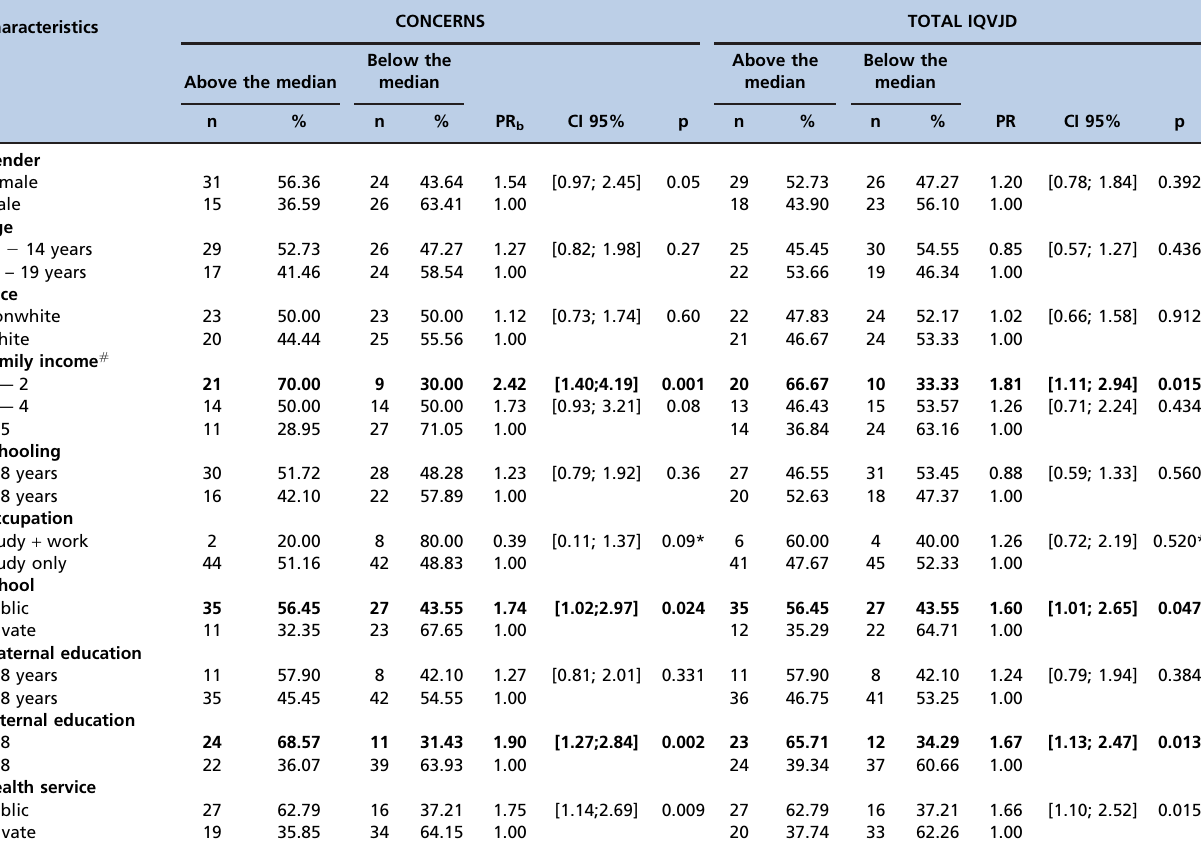
Table 2B - Bivariate analysis of associations between sociodemographic characteristics and the domains ‘‘Concerns’’ and ‘‘Total